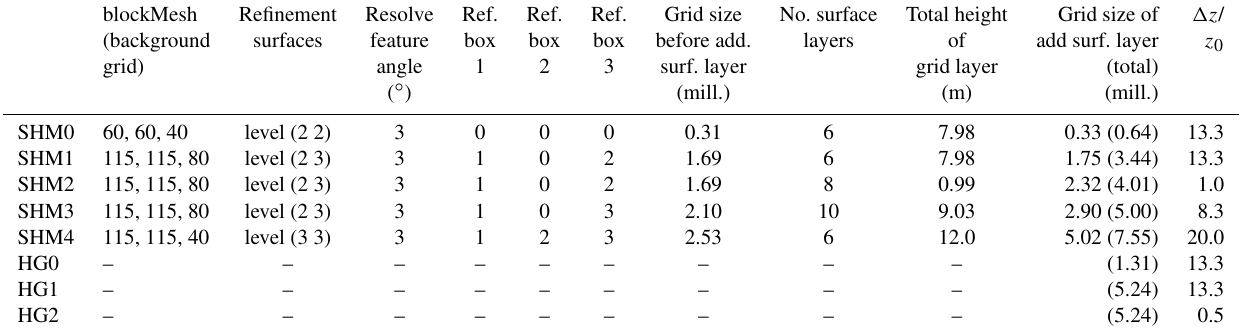
Table 2. Askervein Hill: overview of different control parameters used to generate the SnappyHexMesh-created grids. The “blockMesh” column shows the number of grid points in the x , y , and z directions in the background mesh. The “Refinement surfaces” column shows the minimum level of surface refinement relative to the blockMesh-created background grid (first number in the parentheses) and the maximum surface refinement level (second number in the parentheses), which is used if a cell intersection angle (angle between two adjacent cells) is greater than resolveFeatureAngle (number shown in column three). The “Ref. box” 1–3 columns show the local grid refinement level relative to the background grid. The following three columns show grid size before the addLayersControls option is used, the number of added surface layers, and a total height of grid zone corresponding to added surface layers. The last two columns show the number of grid points in added surface layers (total number of grid points in the entire mesh shown in the parentheses) and the ratio between the first cell center height and the roughness length. The definition of all grids, including the HypGrid-based ones, together with the corresponding grid sizes is also included. Positions of refinement boxes, surface layers and background grid are indicated in Fig. 3. SHM0–4 are the SnappyHexMesh-based grids and HG0–2 are the HypGrid-based ones.